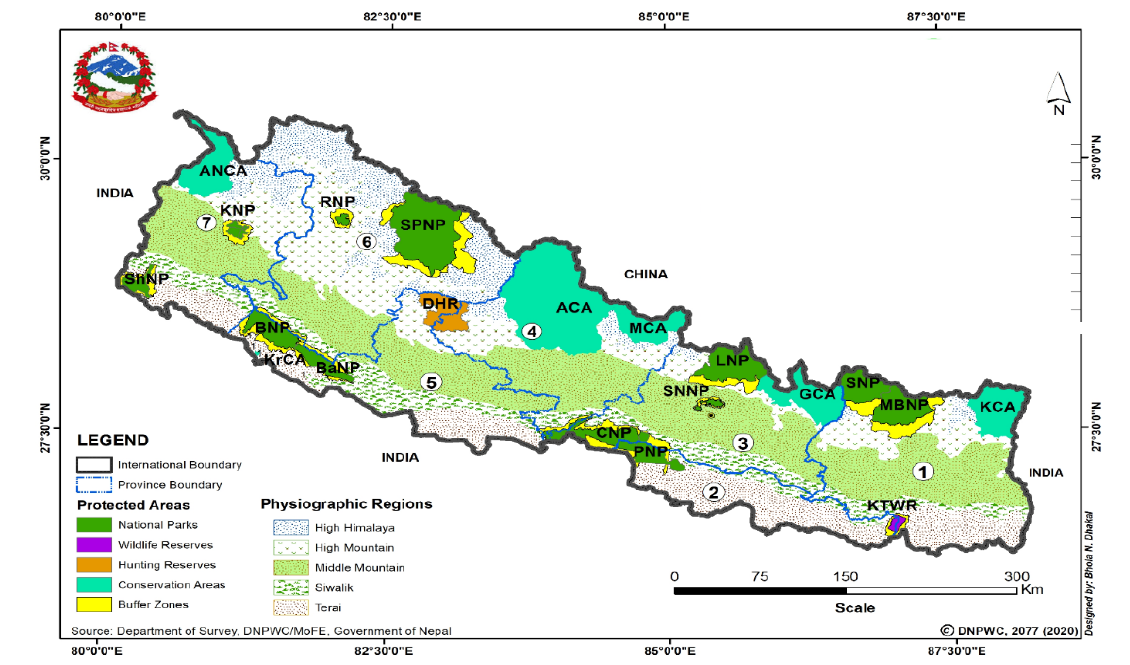
Figure 2. Physiographic feature of Nepal. (Source: Department of National Park and Wildlife Conservation).